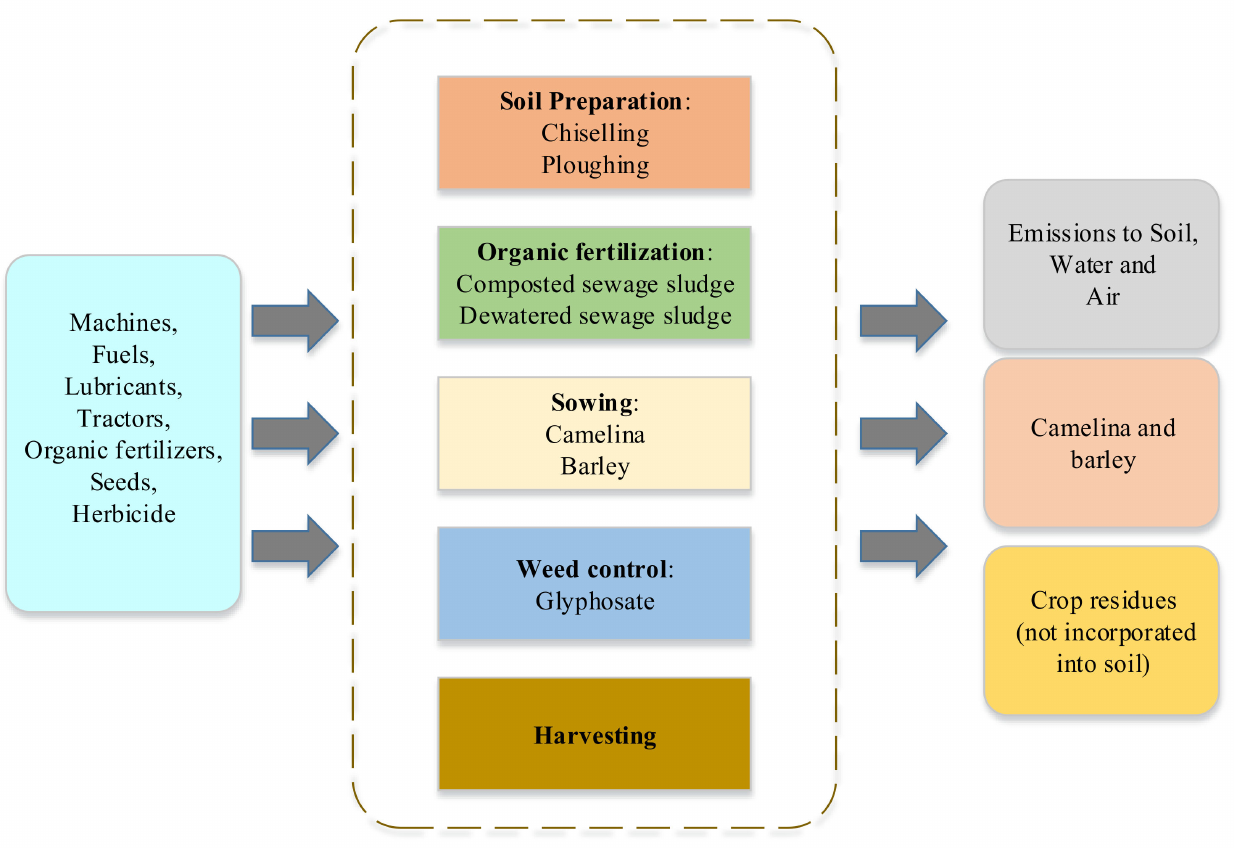
Figure 2. System boundary for camelina-barley-camelina crop rotation fertilized with composted sludge and dewa- tered